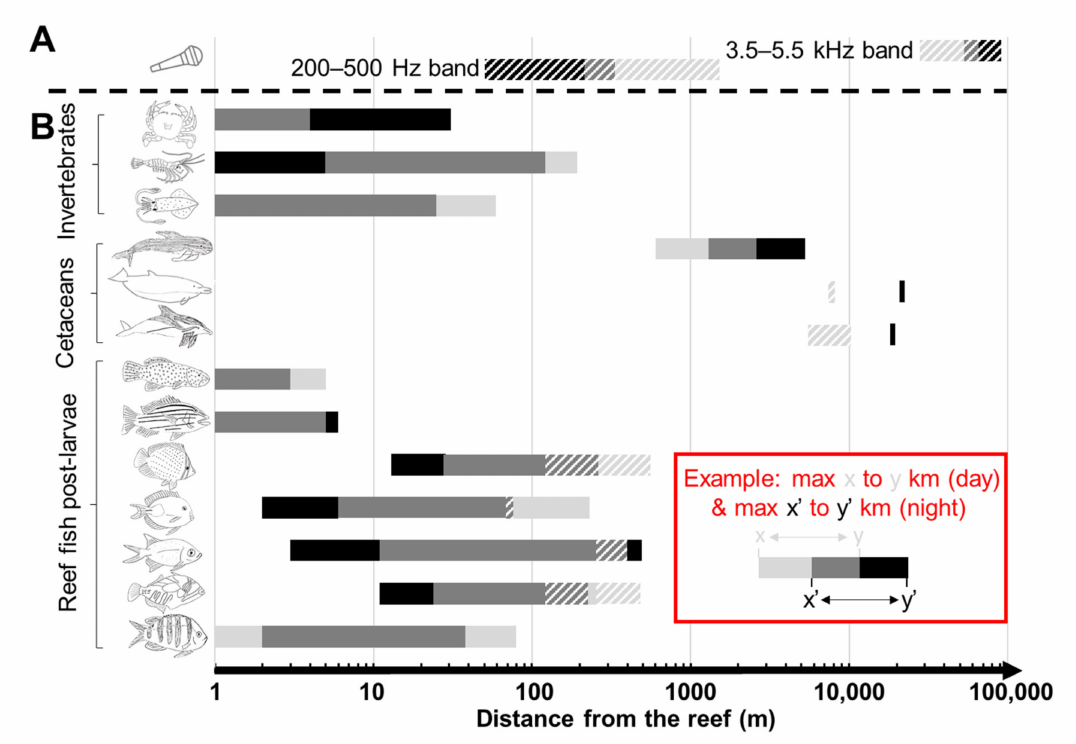
Figure 8. ( A ) Maximal distance of detection of the ambient noise level (ANL) of the fish chorus (200–500 Hz) and benthic invertebrate (3.5–5.5 kHz) bands and ( B ) Maximal distance of detection of the ANL of the reef by different species from the literature, from bottom to top: fish (Pomacentridae, Balistidae, Holocentridae, Acanthuridae, Chaetodontidae, Lutjanidae and Serranidae), cetaceans ( Stenella , Mesoplodon and Globicephala ) and invertebrates (squid Loligo , shrimp Palaemon and crab Ovalipes ). See Table S3 for details of the individuals used. Light grey = diurnal values, black = nocturnal values, dark grey = overlap between diurnal and nocturnal values. Hatched parts correspond to values possible only when the wind is less than 6 knots, the average speed in Polynesia). The red box is an example to show how to read the